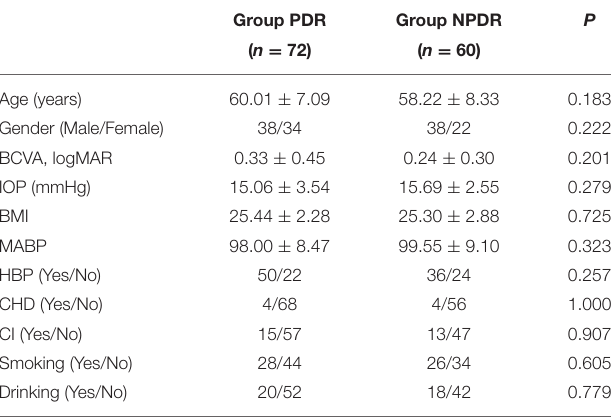
TABLE 1 | Patient demographics and clinical